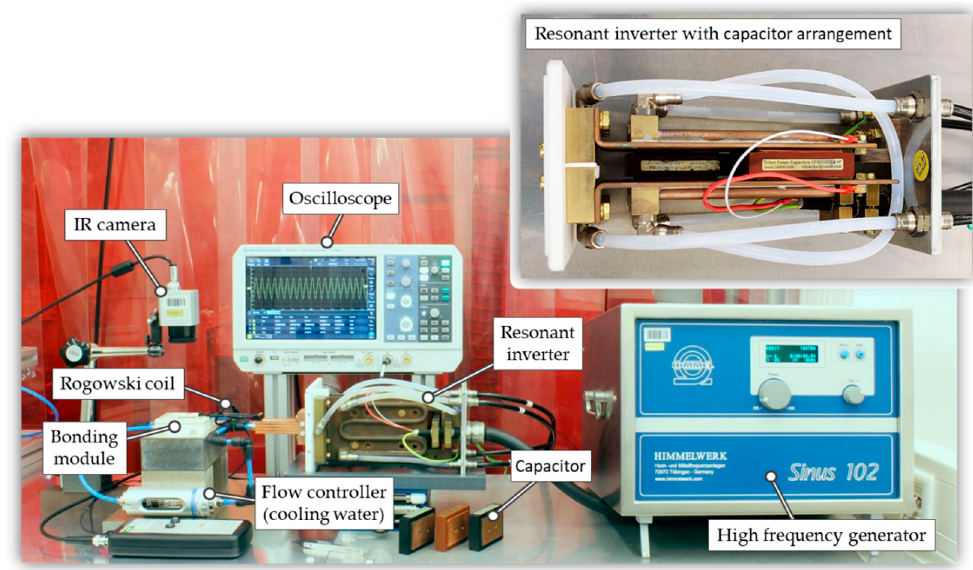
Figure 14. Inductive heating setup with high frequency induction generator, resonant inverter, bonding module and monitoring equipment (Rogowski coil, oscilloscope, flow controller).